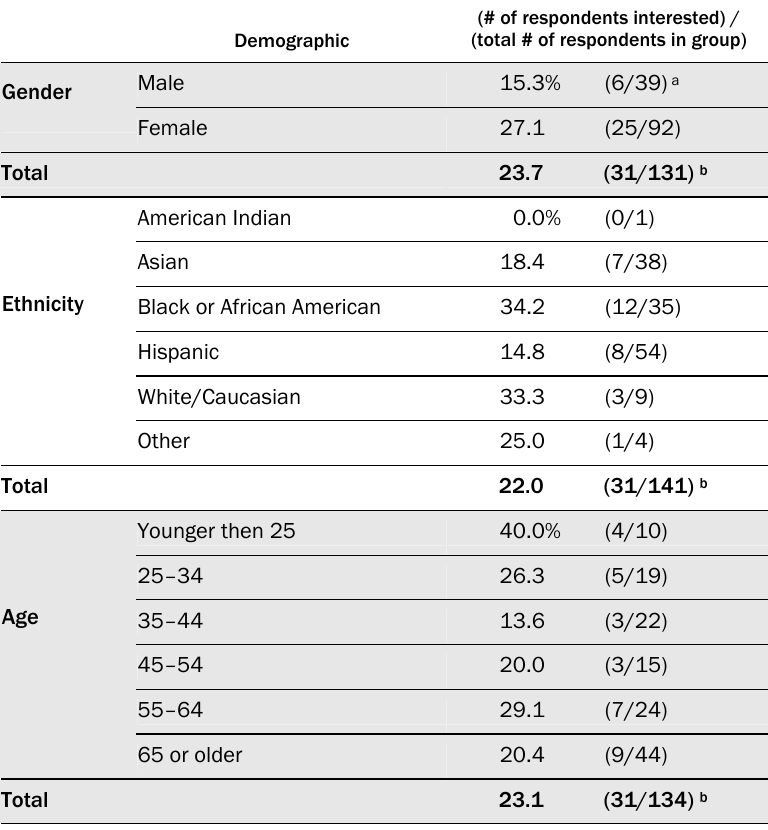
Table 4: Percentage of Each Group That Indicated Interest in Community